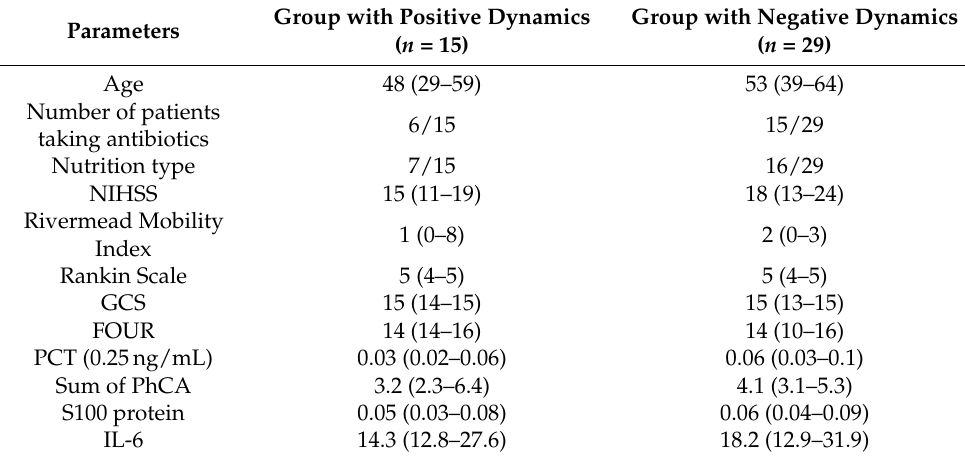
Table 5. Baseline clinical and laboratory characteristics of CCI patients upon admission to the ICU. Quantitative data are shown as median (1st and 3rd quartile); There is no significant differences between two groups of CCI